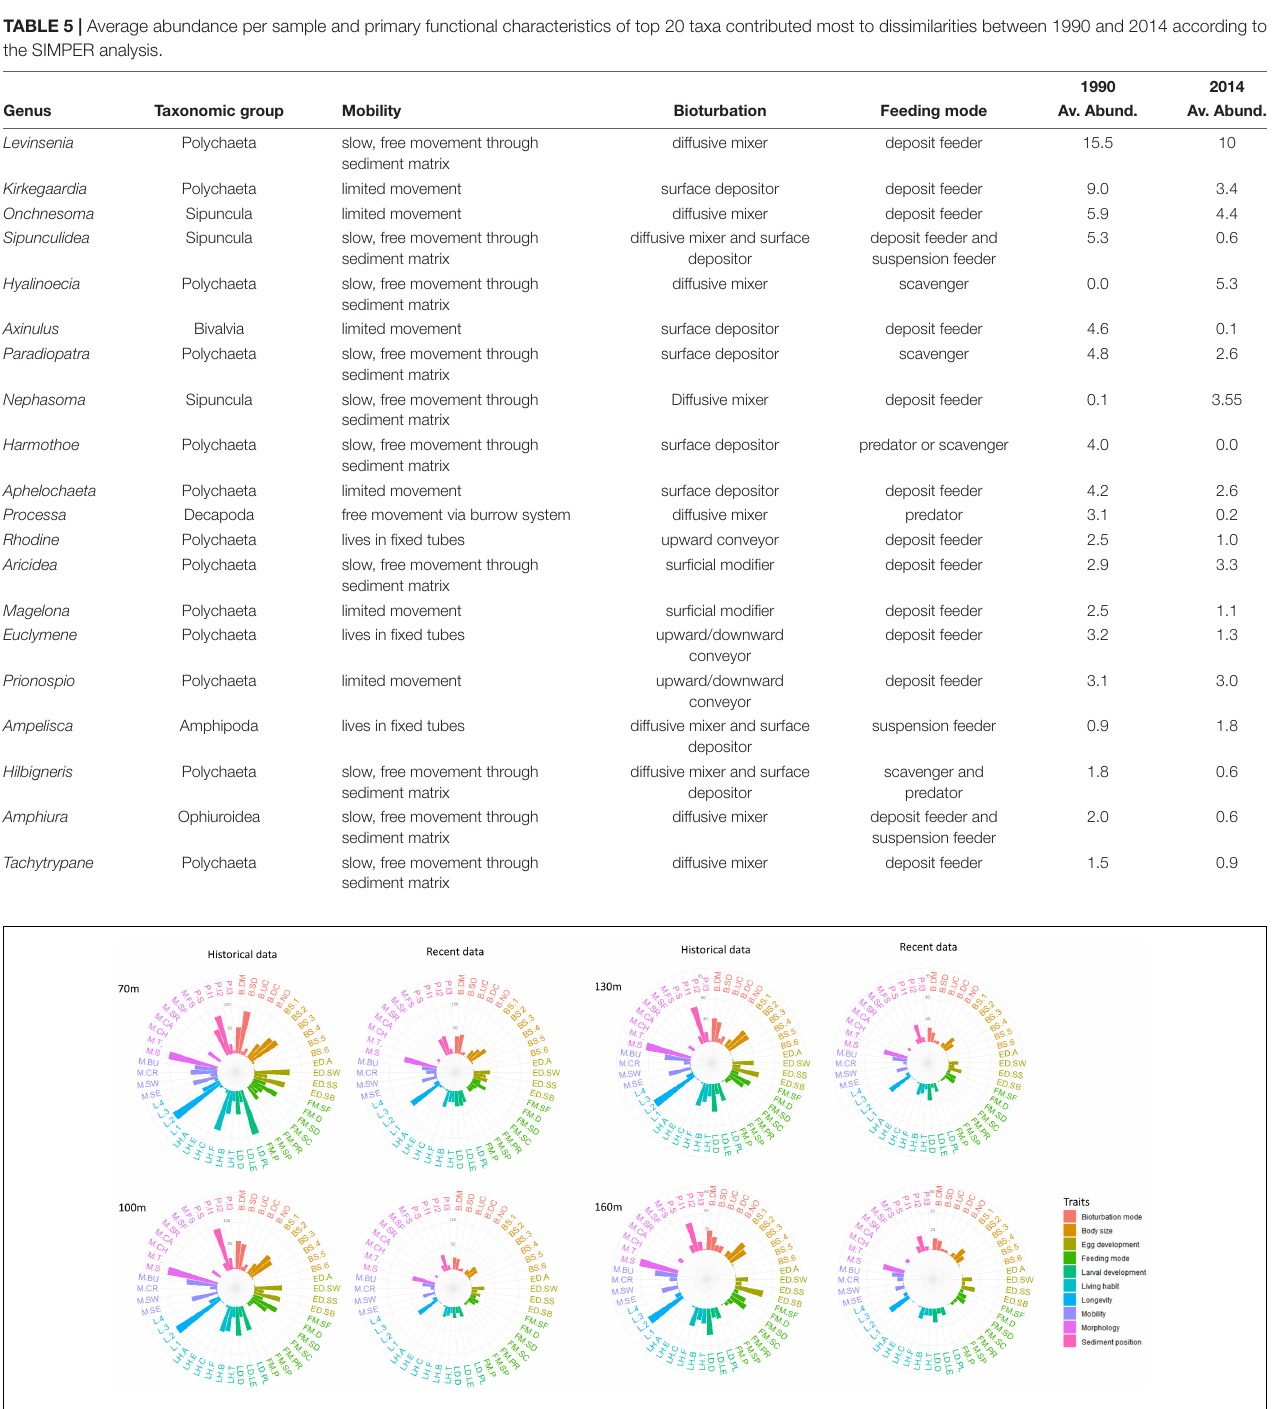
FIGURE 4 | Abundance-weighted means of trait modalities at different sampling depths (i.e., 70, 100, 130, 160 m) for 1990 (historical data) and 2014 (recent data). Colors represent different traits; individual bars represent the trait modalities. For trait modalities codes see Table 2 .